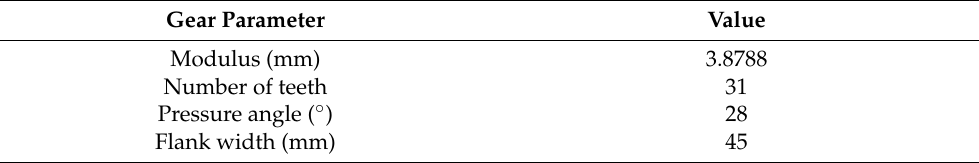
Figure 1. Gear forming grinding equipment: ( a ) experimental gear; ( b ) installed thermocouple; ( c ) wheel dressing; ( d ) coordinate probe; ( e ) grinding temperature measurement; ( f ) machining process. Table 1. Gear